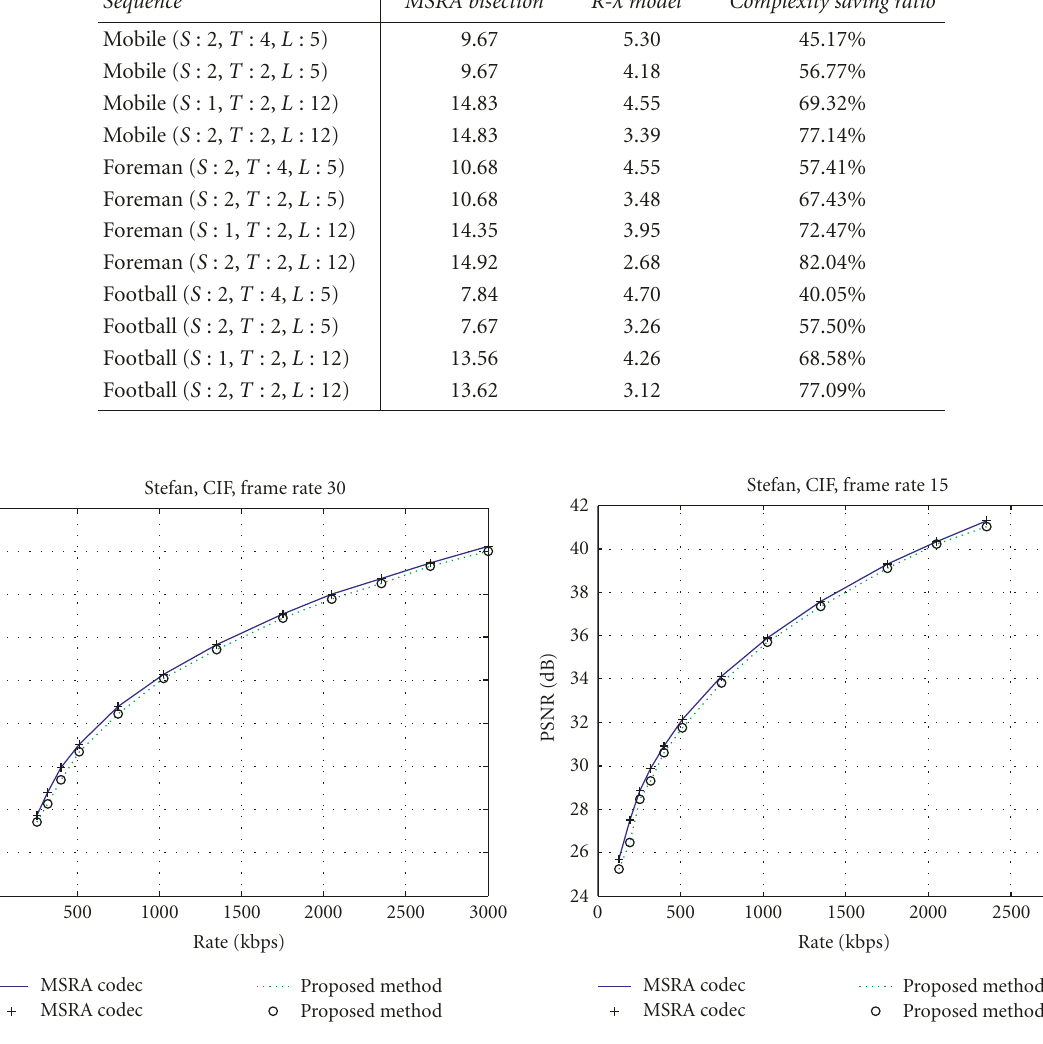
Figure 8: PSNR performance comparison of